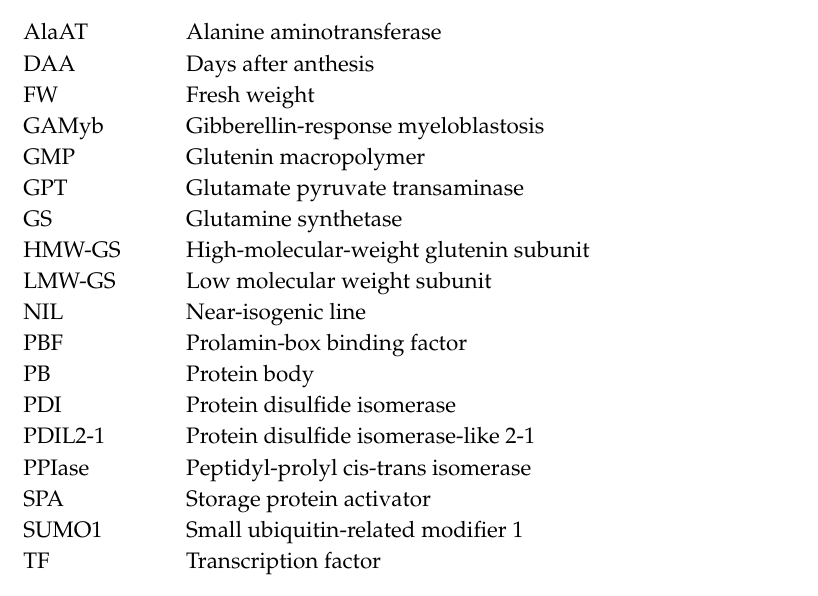
Figure S1. Expression levels of Glu-1Dx2 and Glu-1Dy12 in HMW-D1a and HMW-D1p grains during